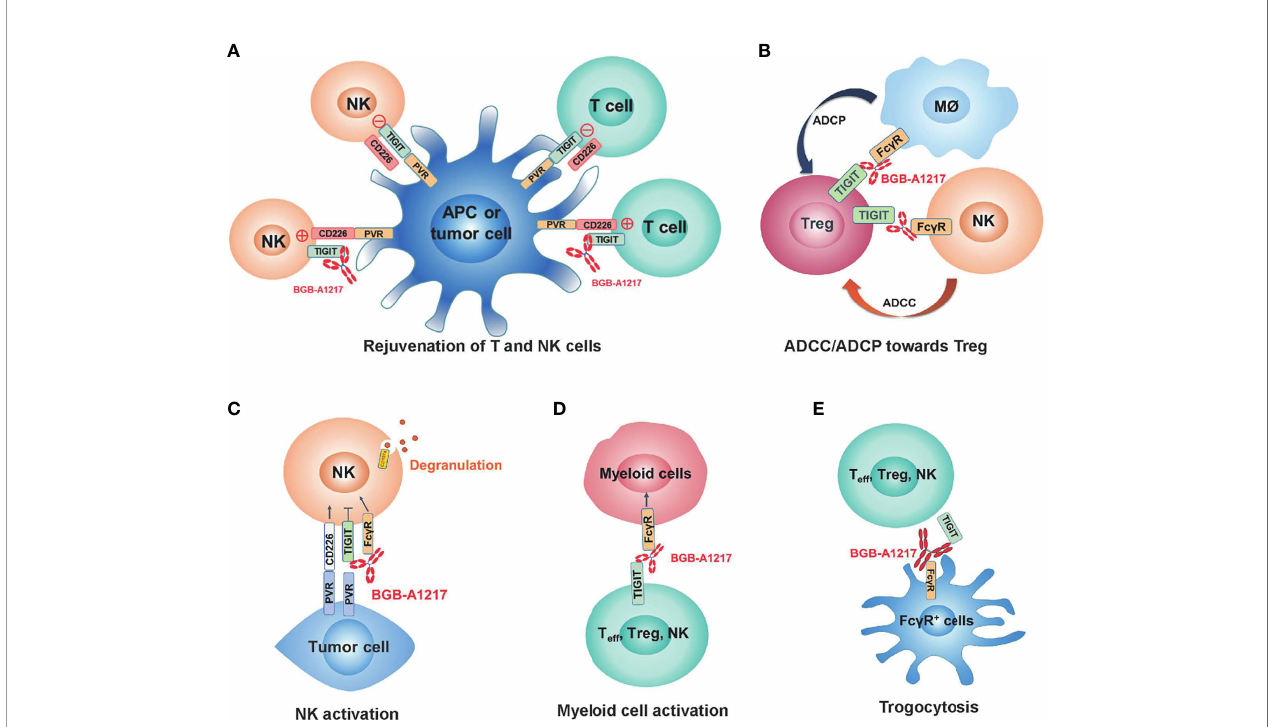
FIGURE 8 | BGB-A1217 elicits strong immune responses and potent anti-tumor ef fi cacy through multiple mechanisms of action. (A) Rejuvenation of T and NK cells. (B) Preferential Treg depletion through ADCC/ADCP. (C) NK activation through TIGIT binding and Fc g R crosslinking. (D) Myeloid cell activation through Fc g R crosslinking. (E) Removal of TIGIT molecules from T cell and NK cell